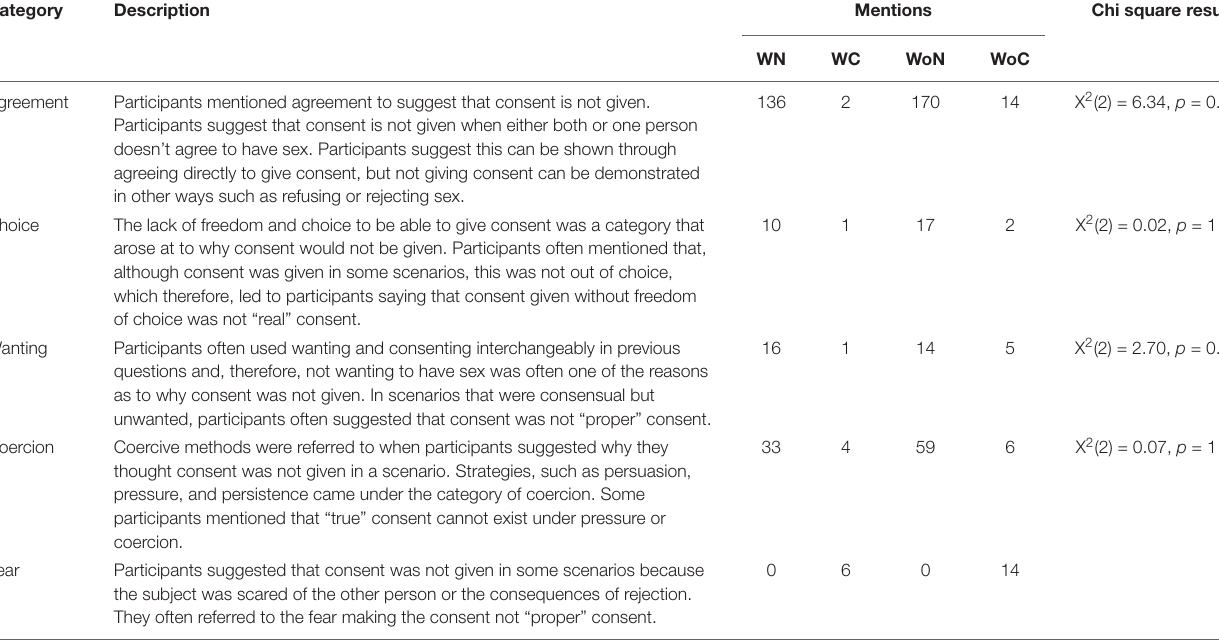
TABLE 4 | Summary content analysis (full analysis presented in Supplementary Table S4 ) for the question “Why do you think consent is not given in this